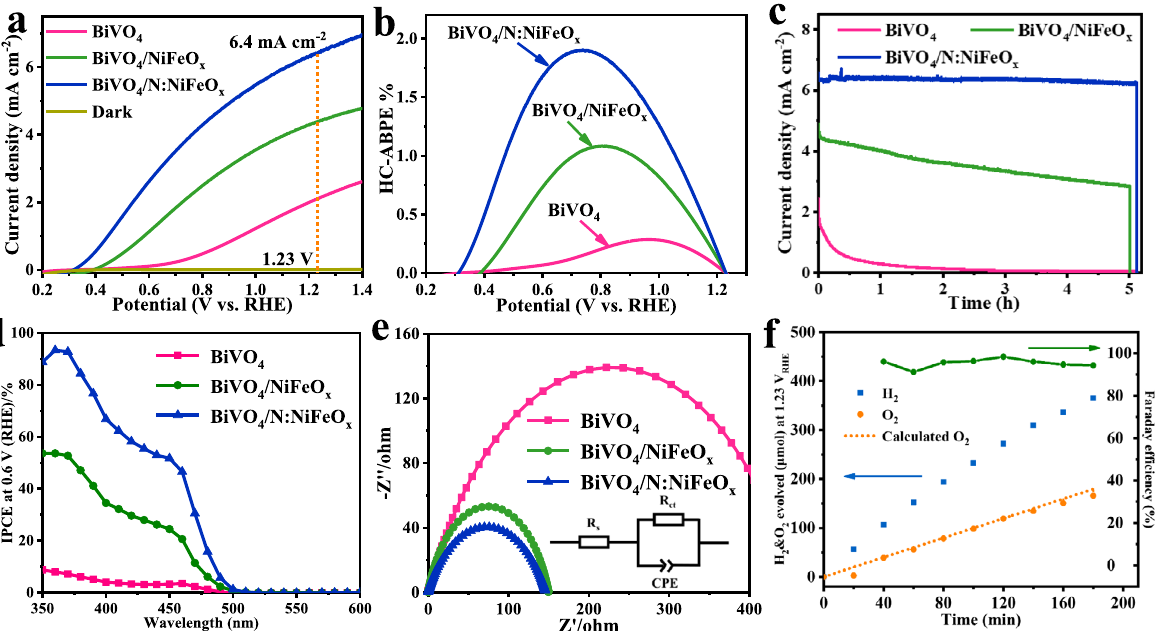
Fig. 2 Photoelectrochemical properties. a Linear-sweep voltammograms (LSV, with a scan rate of 10 mV s − 1 ), b half-cell ABPE (HC-ABPE) results, c I – t stability tests measured at 1.23 V vs. RHE, d IPCE results at 0.6 V vs. RHE and e EIS results at 0.75 V vs. RHE under illumination for BiVO 4 , BiVO 4 /NiFeO x , and BiVO 4 /N:NiFeO x photoanodes. f H 2 and O 2 evolution of BiVO 4 /N:NiFeO x measured at 1.23 V vs. RHE. All the measurements were carried at 0.5 M K 3 BO 3 (pH = 9.5)